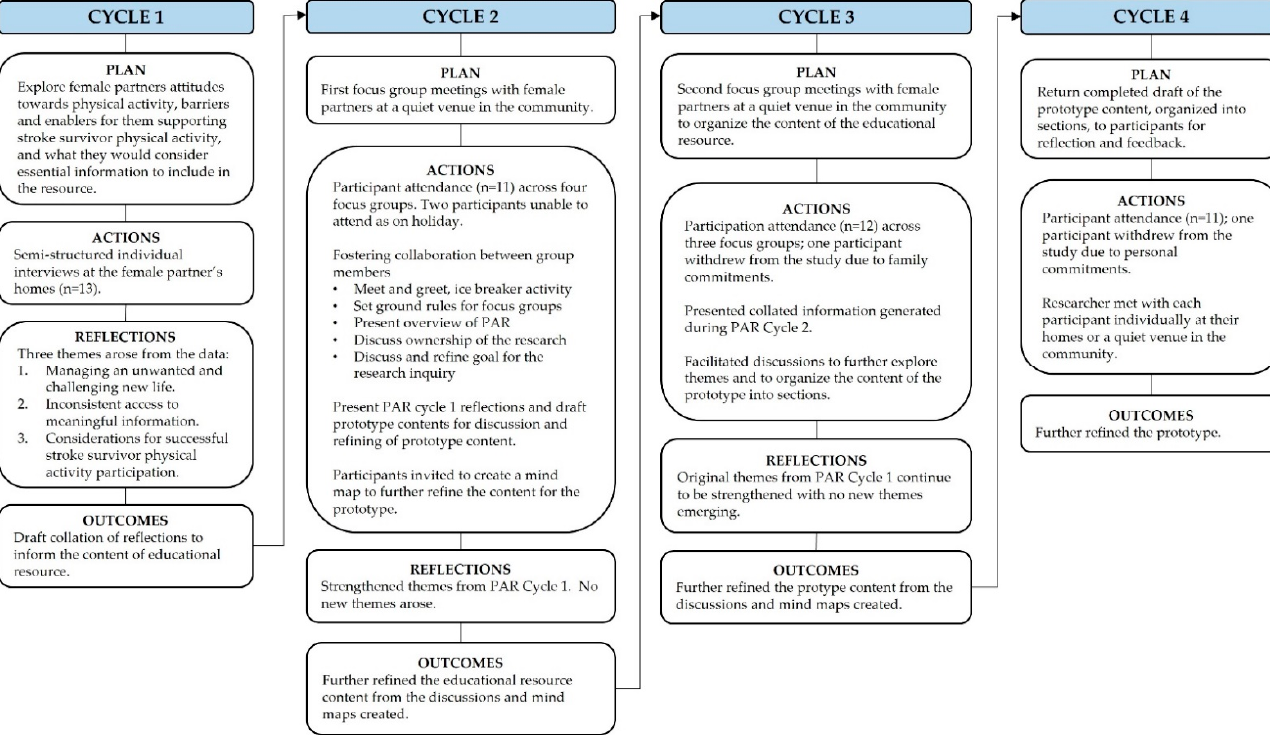
Figure 1. Participatory action research (PAR) cycles of planning, action, and reflection.